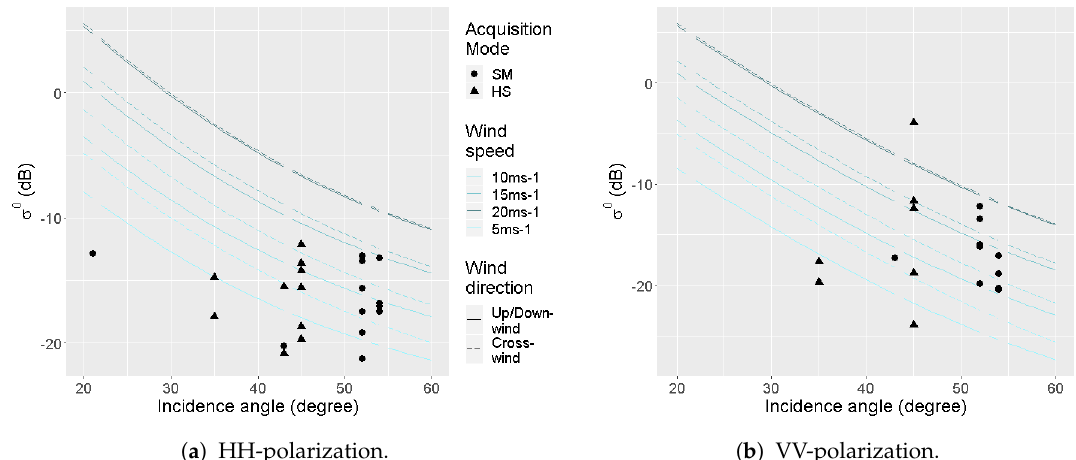
Figure 21. The vessel’s maximum σ 0 (dots) for HH-pol and VV-pol compared to the water surface’s radar return estimations according to different wind scenarios